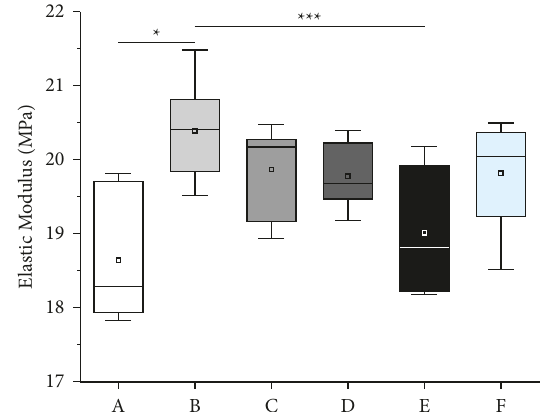
Figure 4: Elastic moduli of resins having different